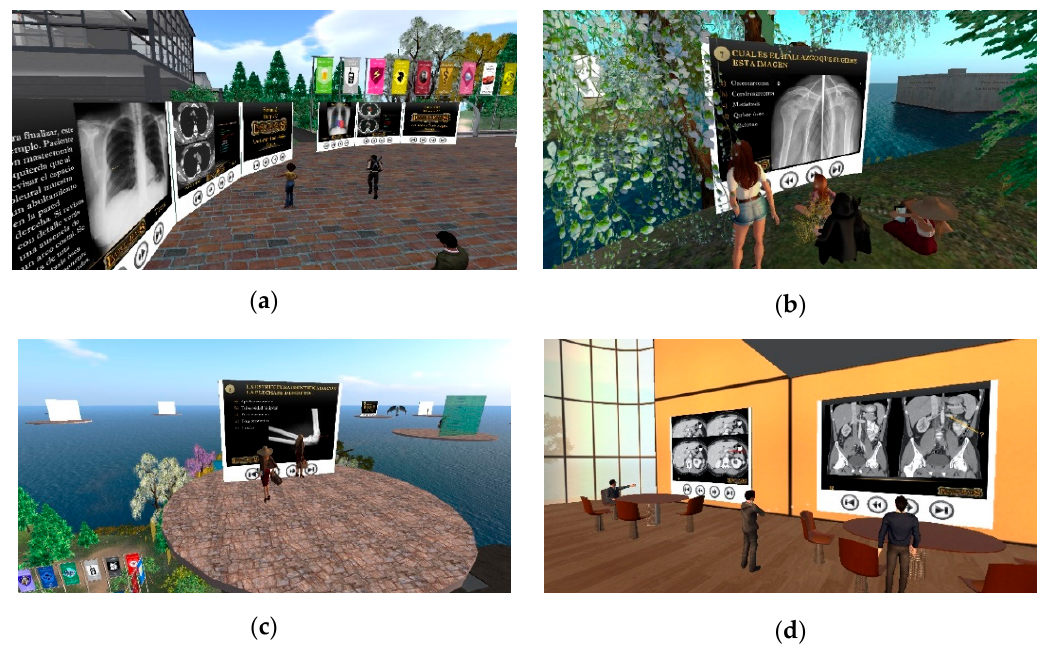
Figure 1. Several screenshots of the 2020 edition of the game League of Rays: ( a ) students watching educational content presented in sets of three panels; ( b ) a group of participants in front of the panel with the multiple-choice test corresponding to one of them. ( c ) Students doing an individual assessment on floating platforms in the sky; ( d ) several participants reviewing the assessment tasks by team.